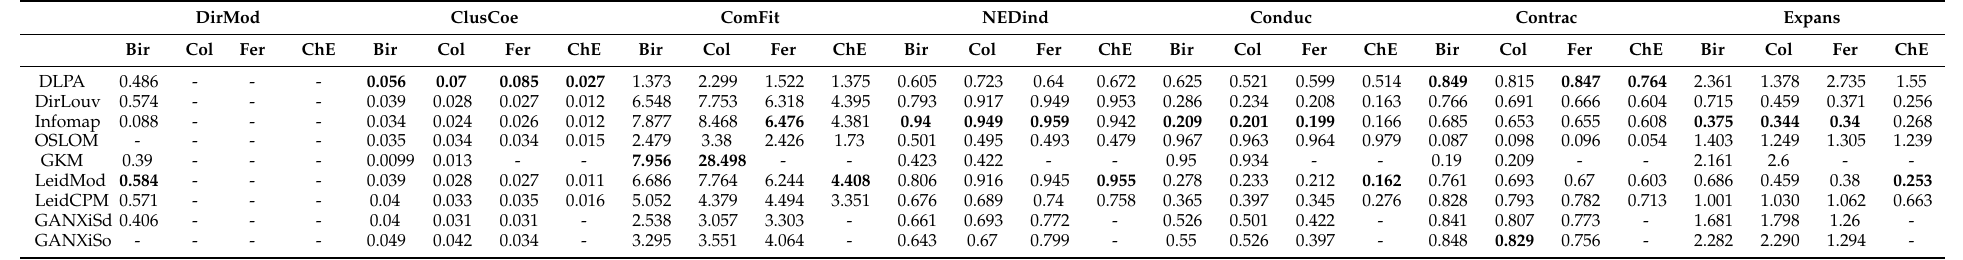
Note. The best results for each case/algorithm are highlighted in